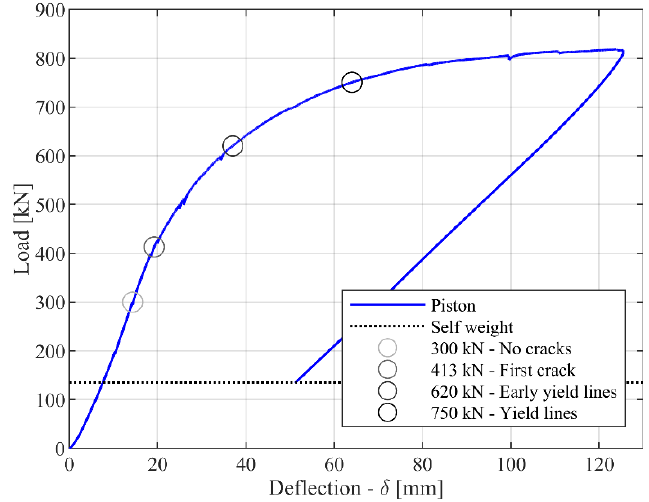
Figure 11. Load/deflection curve—lab test.